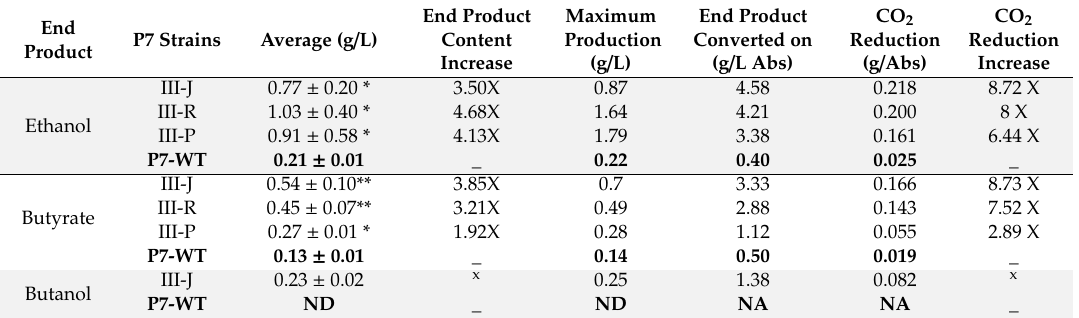
Figure 6. End products identified for the three P7-EMS mutants on CO 2 after three transfers. All three P7-EMS mutants presented stable and increased ethanol, butyrate acid, and butanol production when compared to the P7 wild type. Table 2. End products detected for Clostridium carboxidivorans P7 wild type and the novel mutagenized P7-EMS